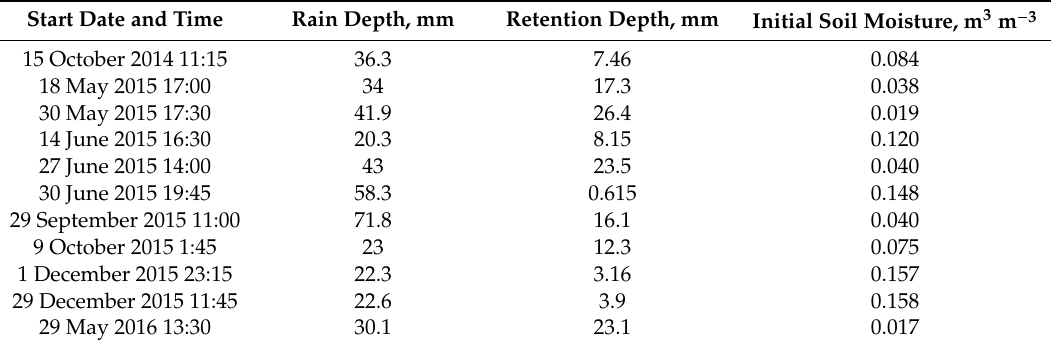
Table 2. Details for 11 events which exceed 20 mm in total depth. Retention depth is calculated as the di ff erence between rainfall and runo ff depth. Initial soil moisture is the average of the four sensors for the timestep preceding the onset of rain.